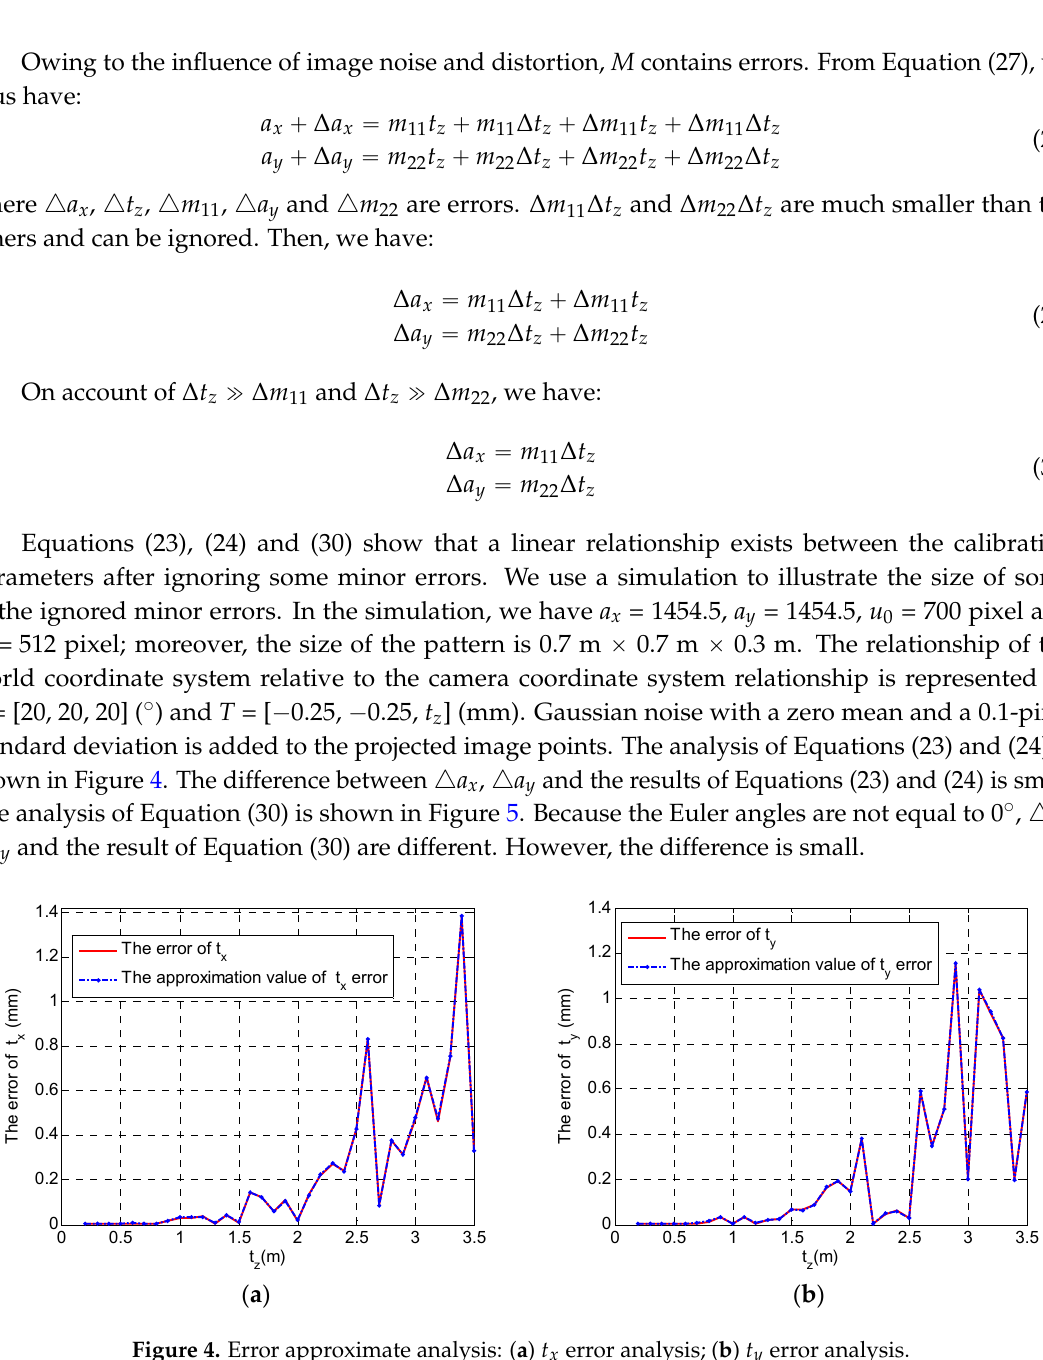
Figure 4. Error approximate analysis: ( a ) t x error analysis; ( b ) t y error